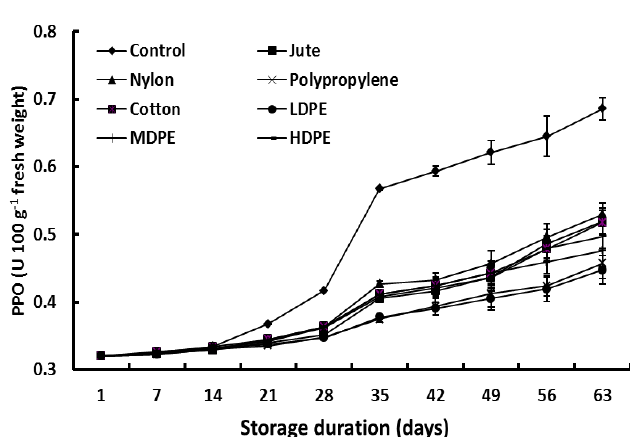
Fig. 6: Radical scavenging activity (RSA) in potato tubers stored using dif- ferent packaging materials was highest by the end of the storage pe- riod when stored in polypropylene. Vertical bars show ±SE of means (n-3). Interaction between storage intervals and packaging materials was significantly different at p ≤ 0.05.